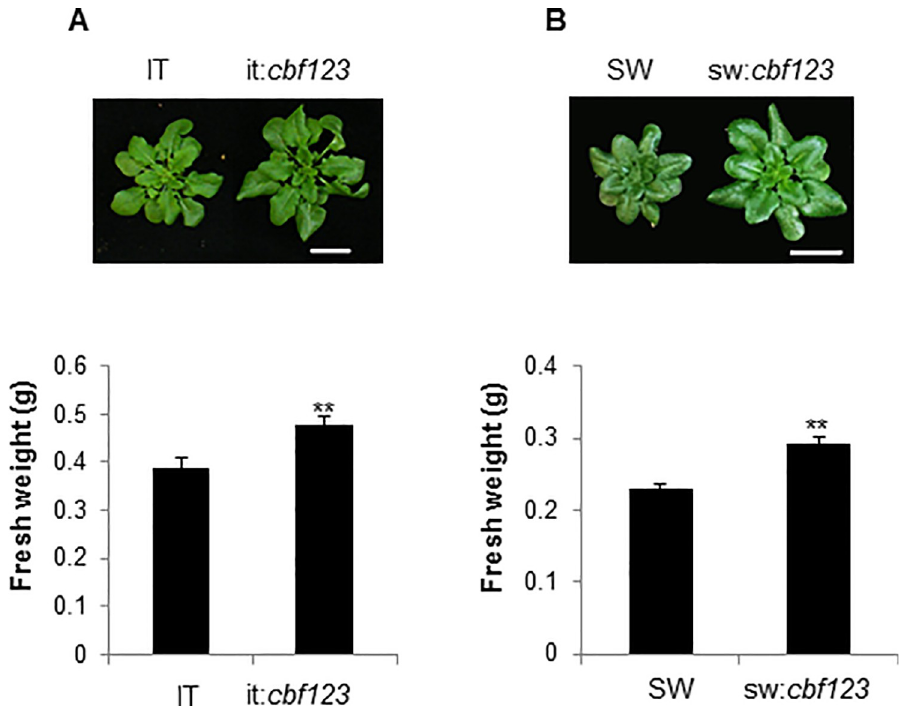
Fig 7. The IT and SW CBF pathways retard plant growth at low temperature. Plants were grown at 4˚C under a 16-h photoperiod, and fresh weights of aerial parts were measured after 3 months. (A) IT and it: cbf123 ; (B) SW and sw: cbf123 . The white bar represents 1 cm. Error bars indicate SE (n = > 15 plants). Asterisks indicate a significant difference between WT and the cbf123 triple mutant (Student t-test, P < 0.01).